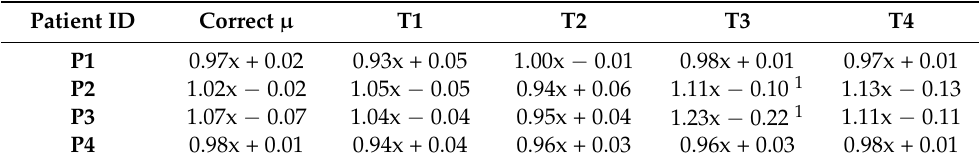
Table 1. Summary of linear regression results for comparison of BPET reconstructions with reference PET. The linear regression is given as a line equation with slope × x + intercept. The “correct µ ” column shows the results with the µ -map obtained from the CT of the patient that was imaged. Patient ID Correct µ T1